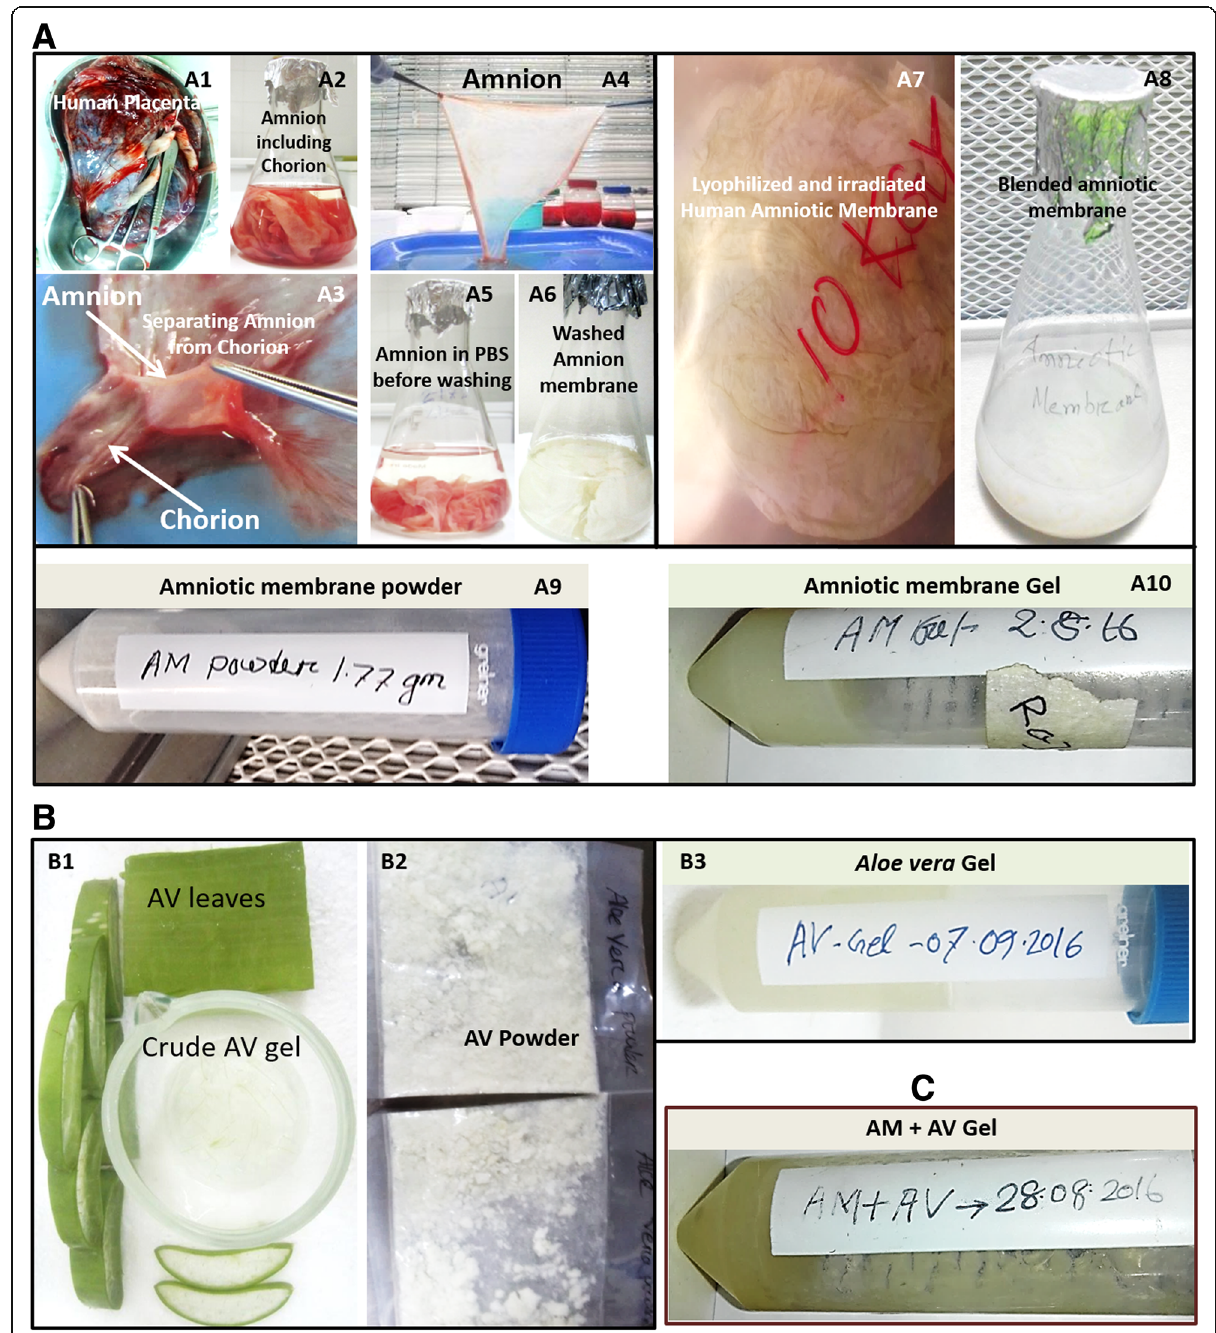
Fig. 1 Processing of amnion membrane and Aloe vera and physical appearance of the formulated gels. a Preparation of amniotic membrane from human placenta (a1, a2, a3, a4, a5 and a6). The dried lyophilized amniotic membrane was 10KGy gamma irradiated and blended. Then the freeze-dried powder was used to formulate AM gel (a7, a8, a9 and a10). b Aloe vera leaves (b1) and freeze-dried Aloe vera extracted powder (b2). The formulated gels AM, AV and AM + AV were shown in a10, a3, and c